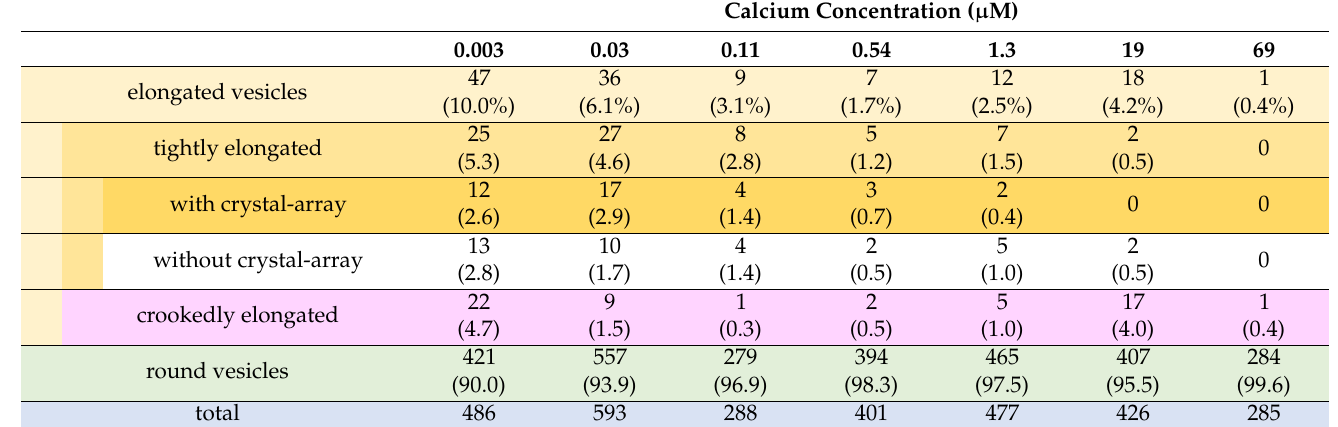
Table 1. Calcium dependence of SR vesicle shape and disposition of the Ca 2+ -ATPase particles in the absence of ATP. The vesicles were classified, and the number of each type of the vesicle was counted at ~0.003–69.0 µ M Ca 2+ (see text for details); details of the classification are given in Table S1. First, all the vesicles (major axis > 0.065 µ m) were classified as either elongated (ratio of the major axes to the minor axes ≥ 2) or round (ratio of the major axes to the minor axes < 2), then the elongated vesicles were sub-classified as tightly or crookedly elongated. The disposition states of their surface particles were classified as three types: ‘crystalline’, ‘tight assembly of crystal patches’ and ‘unclear’. The vesicle populations (46–222 vesicles) within the 5.4 µ m by 5.4 µ m electro-microscopic views, were subjected to the vesicle classification (see text for details); 2–4 views were analyzed at each calcium concentration. At 0.003–0.54 µ M Ca 2+ , more than five tightly elongated vesicles were present